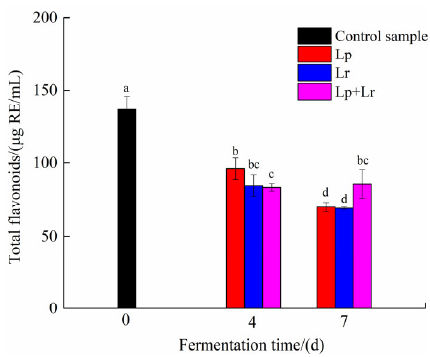
Figure 4. Total flavonoid content of edible grass during fermentation. Different superscript letters in the columns indicate significant difference ( p < 0.05). Abbreviations: Lp, Lactobacillus plantarum ; Lr, Lactobacillus rhamnosus ; Lp+Lr, mixture of Lactobacillus plantarum and Lactobacillus rhamnosus